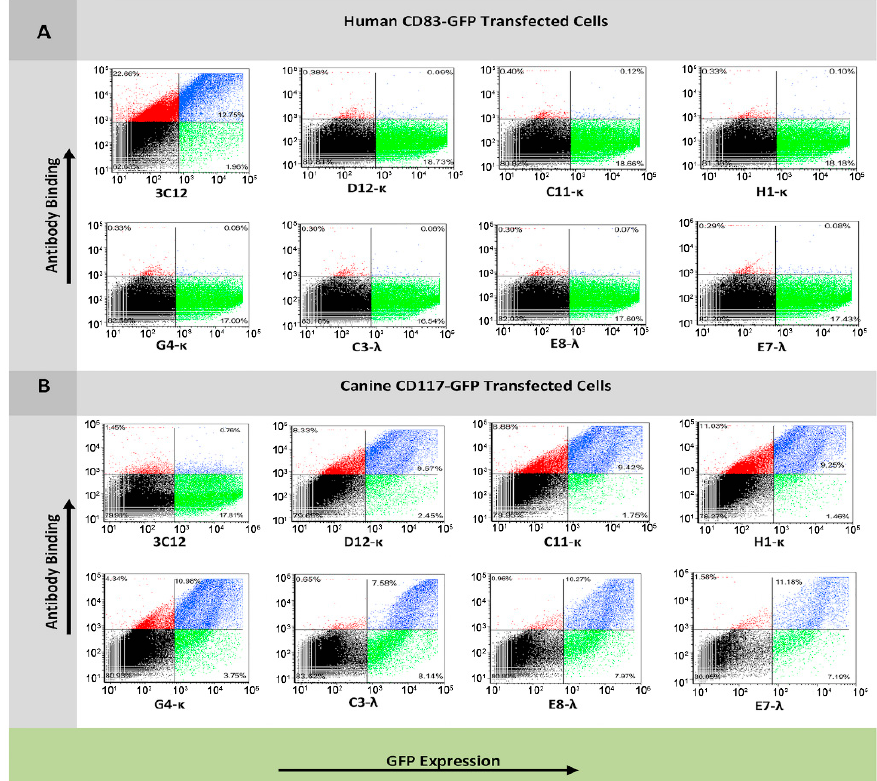
Figure 3. Binding specificity of anti-canine CD117 IgG1 reformatted clones isolated by cell-based biopanning for CD83-GFP- and CD117-GFP-expressing CHO cells by flow cytometry. Cells were transfected with either CD83-GFP fusion plasmid ( A ) or CD117-GFP fusion plasmid ( B ). Cells were incubated with either 3C12 (anti-CD83 monoclonal antibody (mAb)) or one of the seven anti-CD117 mAbs. Antibody binding was detected using Dylight 594 antihuman IgG secondary antibody. Secondary antibody fluorescence ( y axis) was measured using a 561-nm laser and a 630/22-nm filter. GFP fluorescence ( x axis) was measured using a 488-nm laser and a 536/40-nm filter.